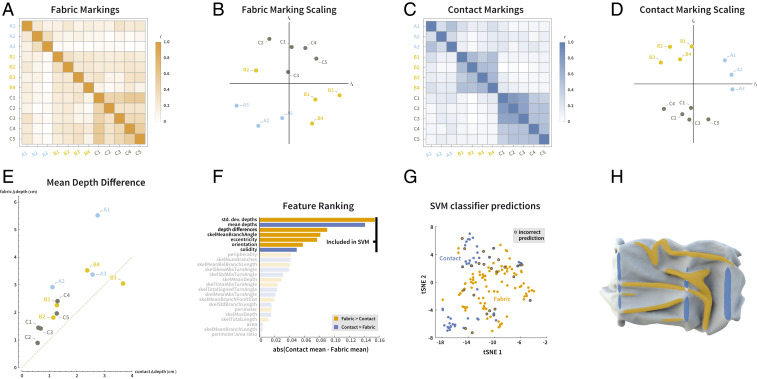
Label colors correspond to the three different underlying surfaces (cyan: A; yellow: B; green: C). (A) Correlations between the fabric maps for all stimuli revealing that participants’ responses were dominated by the differences between drapings. (B) Application of MDS to the correlation matrix reveals a disorderly arrangement in 2D, again reflecting differences in the shape of the fabric across stimuli. (C) Correlations between the contact maps for all stimuli, revealing greater similarities between stimuli that share the same base shapes. (D) Applying MDS to the correlation matrix reveals clear clustering in 2D MDS space. (E) Mean physical depth difference between textile and base shape for fabric and contact markings. Most points are above the diagonal, indicating larger depth offsets for fabric responses than for contact responses. (F) Ranking and selection of features in SVM classifier model: bars indicate magnitude of difference in mean of normalized feature values; color indicates sign (orange: fabric > contact; blue: contact > fabric). Transparency indicates features not used in SVM classifier. (G) SVM classifier predictions of causal assignment for all 154 segmented image regions. Coordinates are 2D tSNE visualization of each region in seven-dimensional (7D) feature space used for classification (orange: predicted fabric; blue: predicted contact; gray rings: incorrect predictions). (H) Predicted causal assignments of image regions for one stimulus (see SI Appendix, Fig. S2 for all stimuli) (orange: predicted fabric; blue: predicted contact).